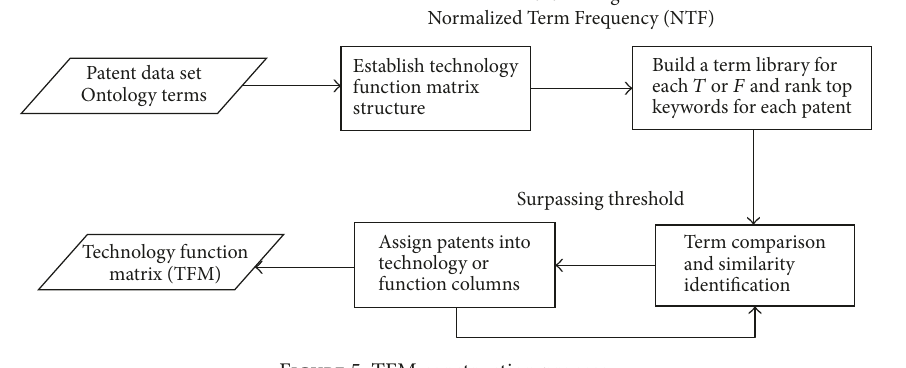
Figure 5: TFM construction process.